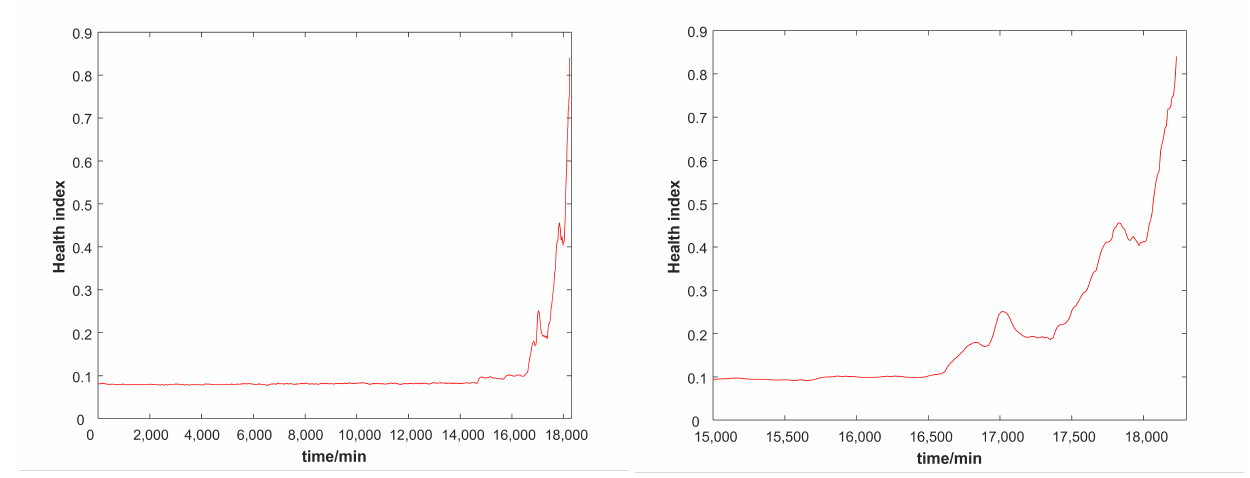
Figure 8. The health indices constructed by the EWMA and the SAE, where the right subgraph is a zoomed graph of the left subfigure in the range of 15,000 ∼ 18,000